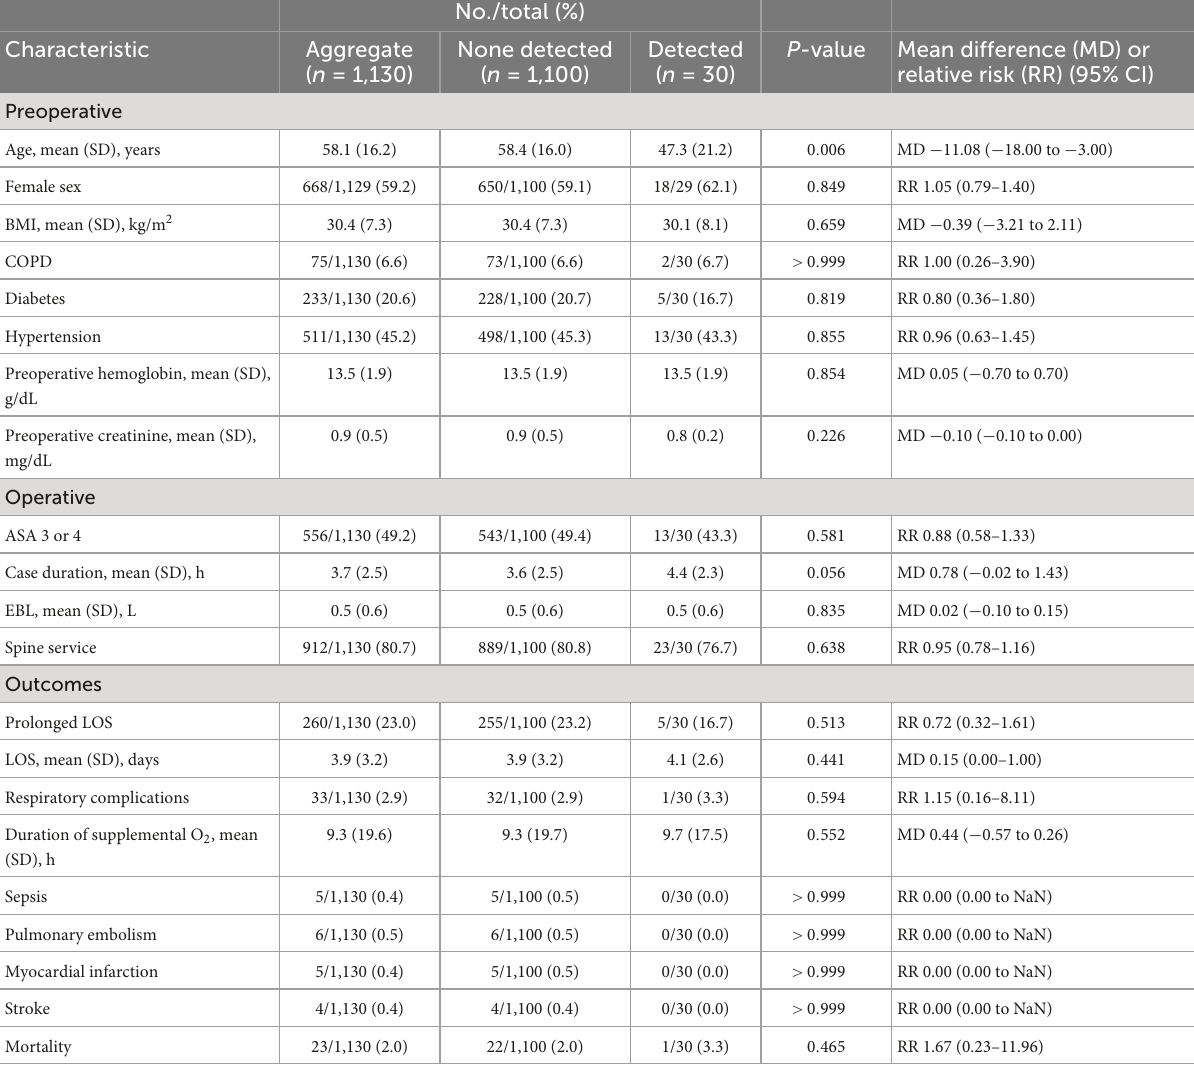
TABLE 1 Demographic data and univariate analyses of SARS-CoV-2